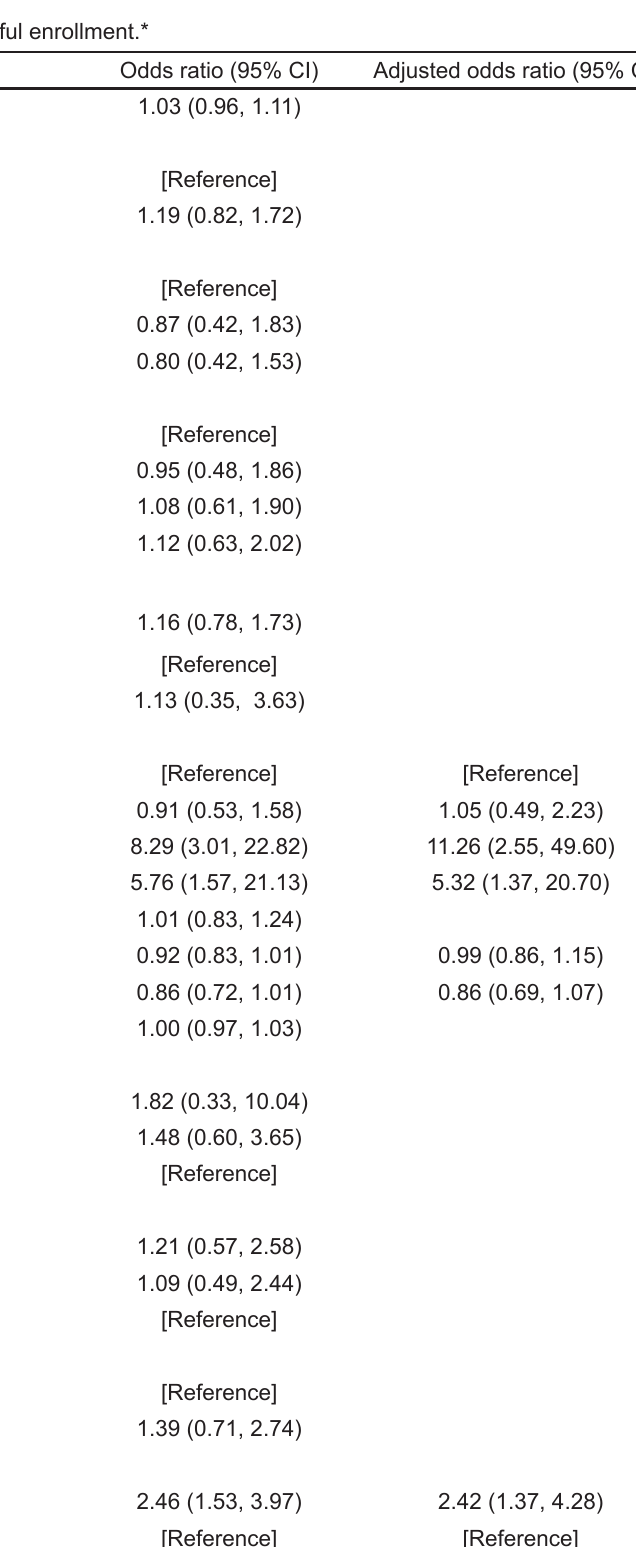
*Odds ratios and 95% CIs were estimated from logistic regression models fit using generalized estimating equations and controlled for correlation between subjects approached by the same enroller using an exchangeable working correlation. Odds ratios >1 signify increased odds of parent/patient consent to participate. † Multivariable model variables were selected based on unadjusted associations with P <0.20. CI , confidence interval; DKA , diabetic ketoacidosis; HbA1c, hemoglobin A1c; T1D , type 1 diabetes; ED , emergency department; mg/dL , milligrams per deciliter; BUN , blood urea nitrogen; ED , emergency department; GCS , Glasgow Coma Scale.